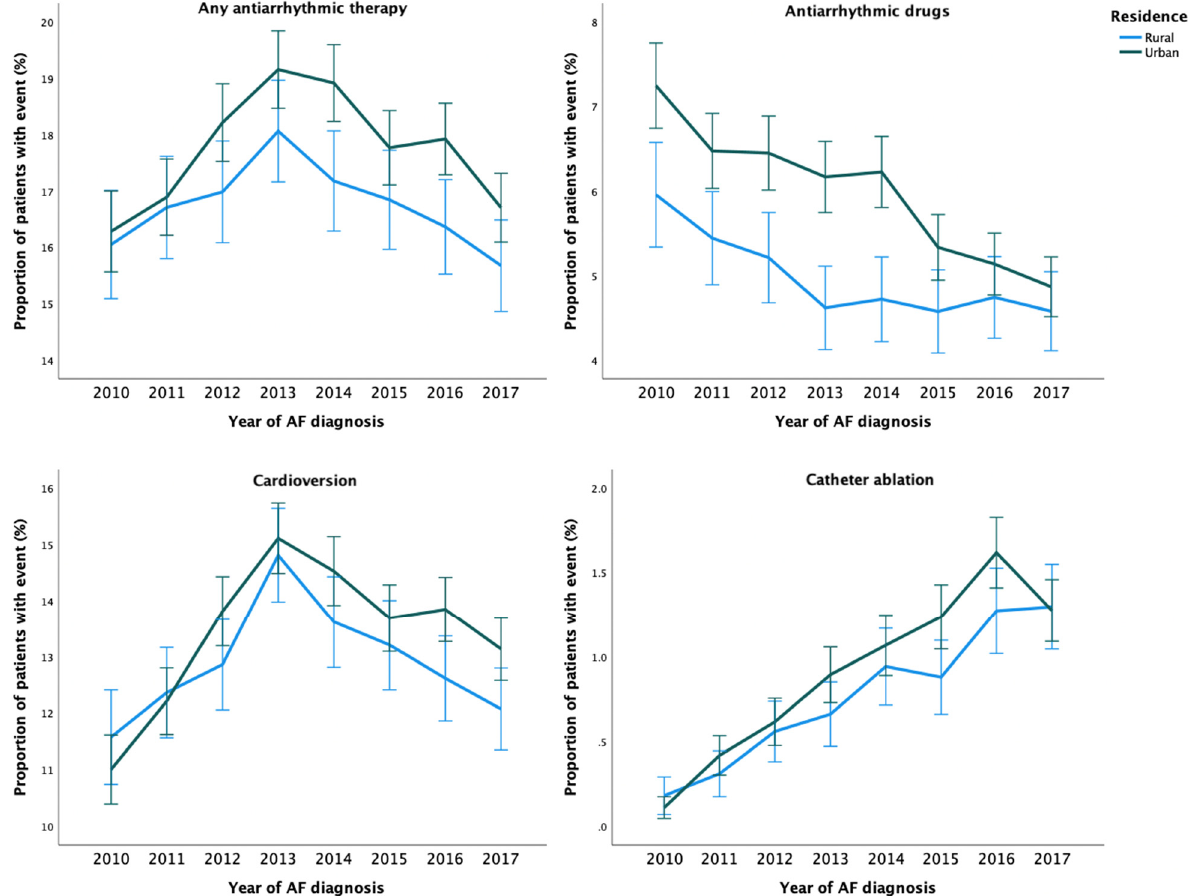
Figure 2. Temporal trends in the proportion of patients with AATs within one-year follow-up from cohort entry according to the year of AF diagnosis.